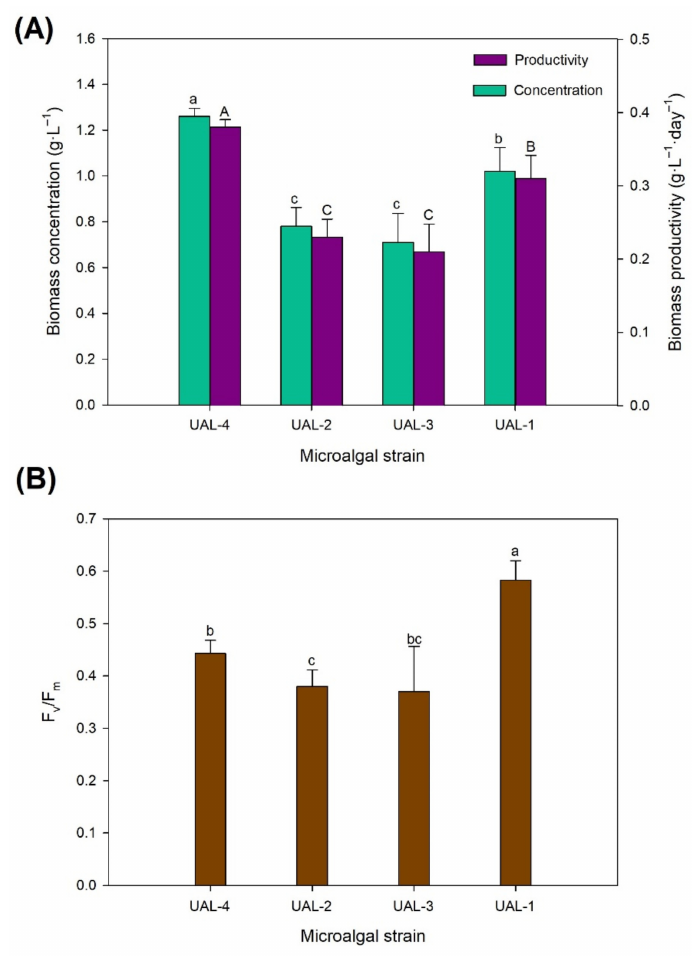
Figure 1. Effect of the culture media on ( A ) biomass productivity and ( B ) maximum quantum yield of the PSII chemistry. Values represent the mean values ± SD. Different letters indicate significant differences ( p <